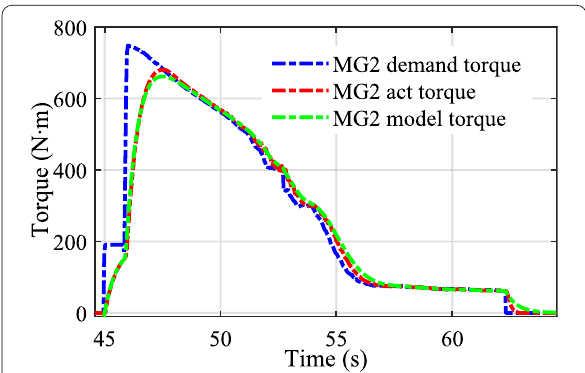
Figure 3 Dynamic model identification results of